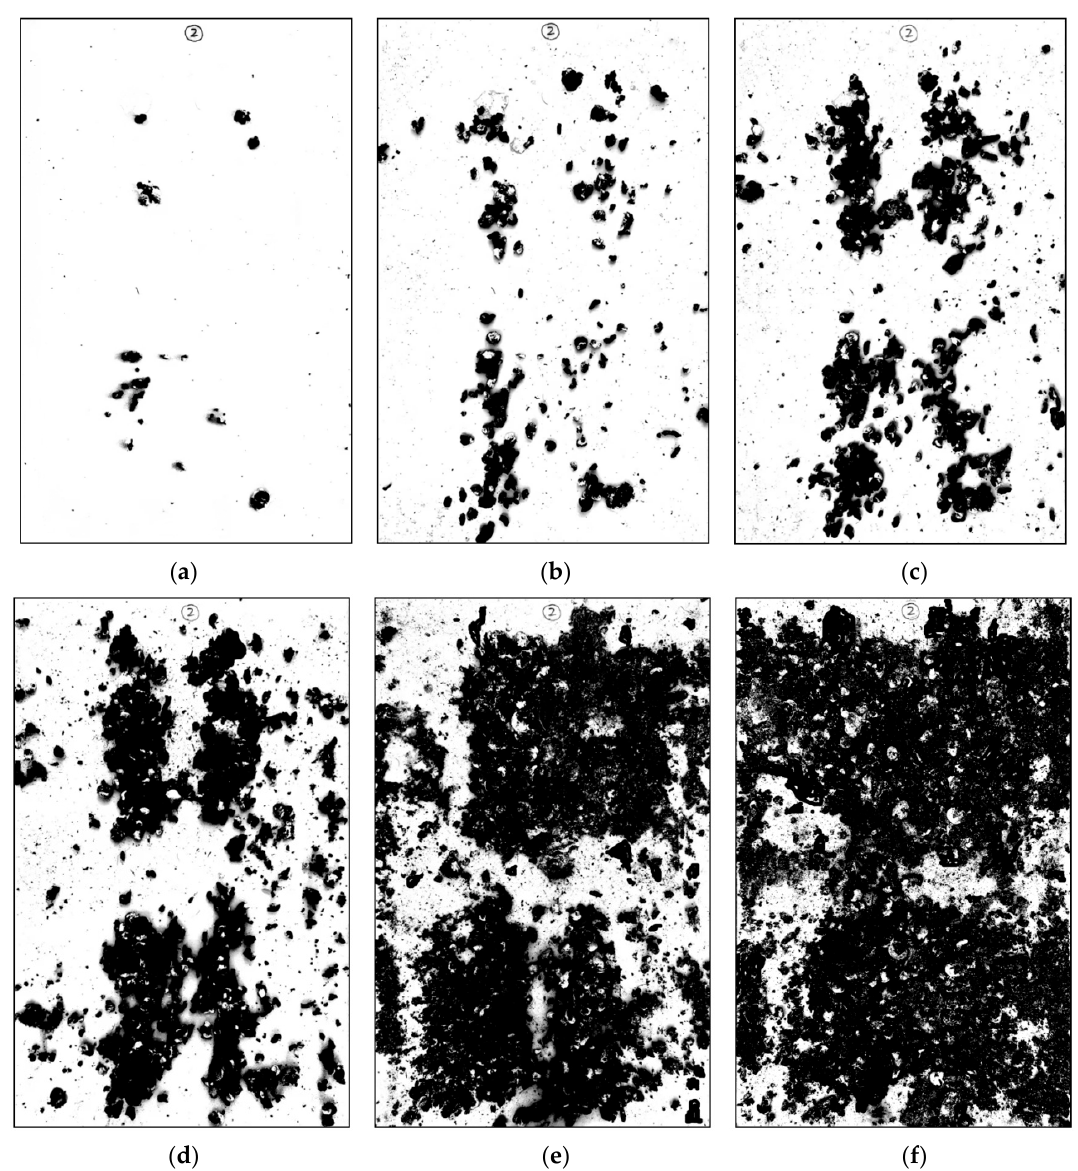
Figure 6. Binary images of the manure on one of the pp plates for the 24 weeks age. Photographs taken at the ( a ) 1st hour, ( b ) 4th hour, ( c ) 8th hour, ( d ) 12th hour, ( e ) 30th hour, and ( f ) 44th